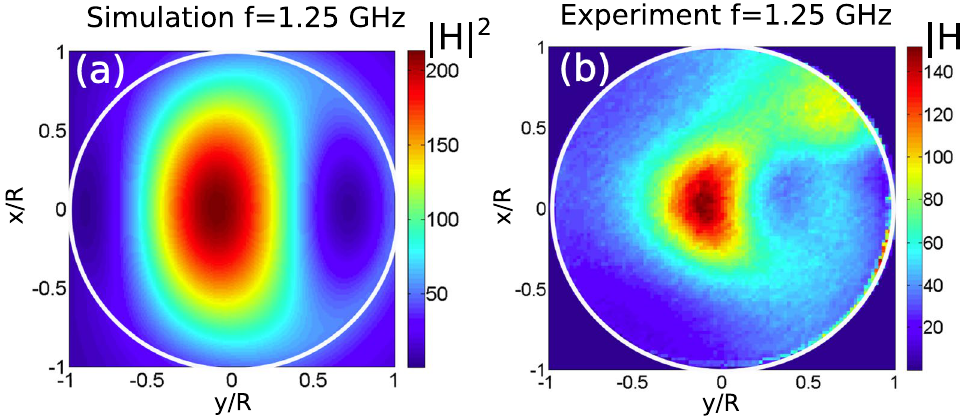
Figure 3. The same as that in Fig. 2, but at the frequency 1.25 GHz for the TM polarized plane wave excitation. The cylinder is filled with distilled water kept at the temperature 25